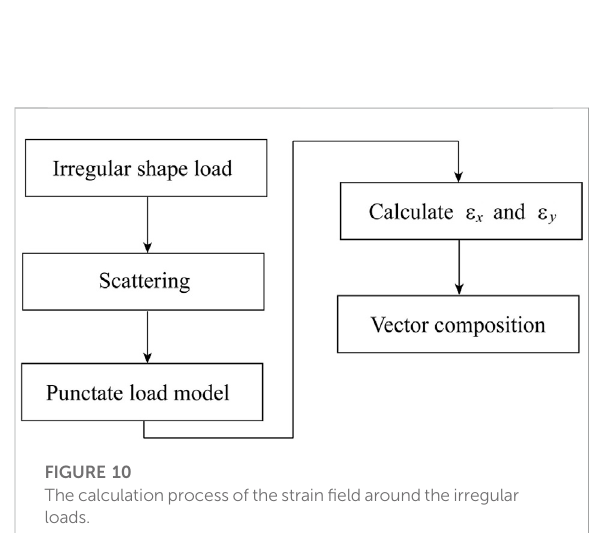
FIGURE 10 Thecalculationprocessofthestrain fi eldaroundtheirregular